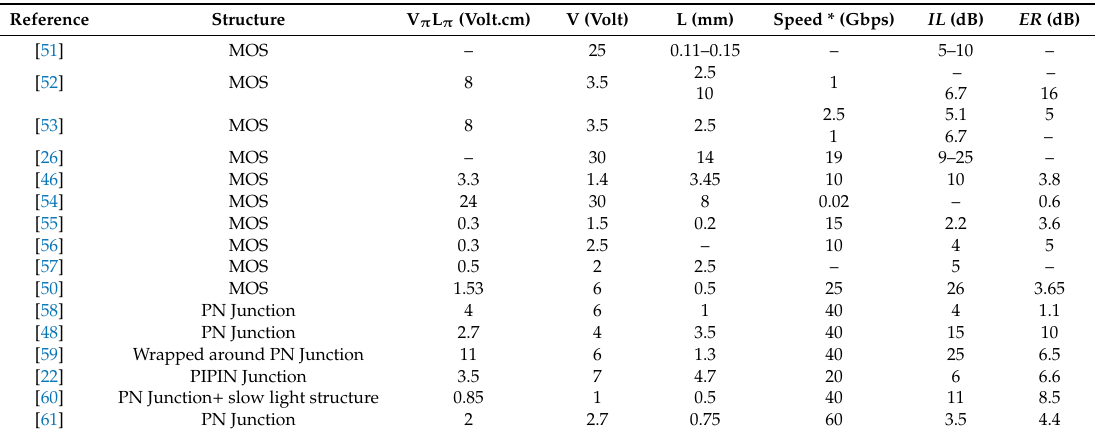
Table 2. Summary of previously published